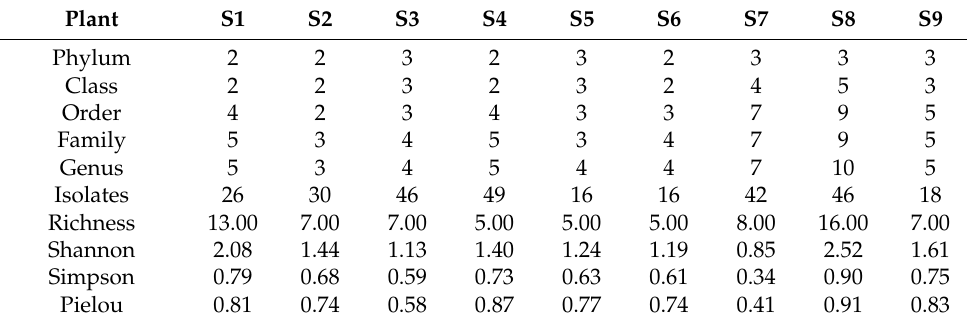
Table 3. Diversity comparison of endophytic bacteria isolated from different samples.